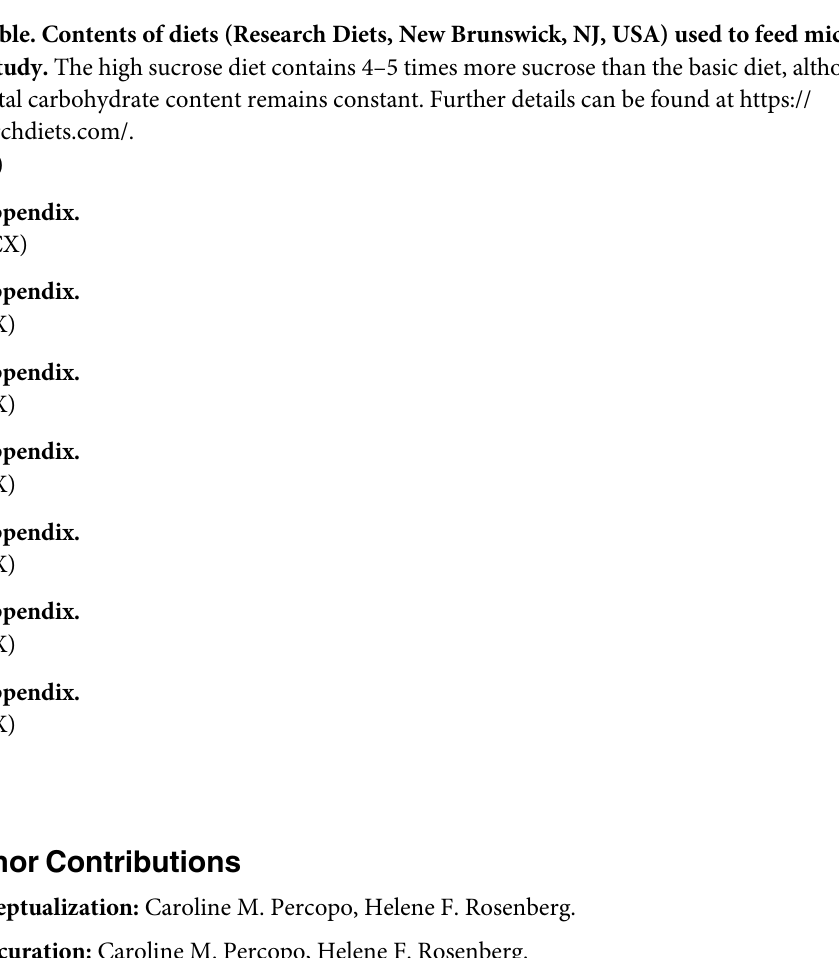
S3 Fig. Profiler signals from cytokines detected in lysates of eosinophils isolated (as shown in Fig 4A) from Aa -challenged mice maintained on ( A ) high-sucrose or ( B ) high- fat diets normalized to those from Aa -challenged mice maintained on a basic diet. Shown are the results presented from three independent experiments; each point represents n = 5 mice as described in the Methods. Arrows indicate no increase over signal detected in mice on the basic diet (i.e., fold change = 1.0); § p < 0.001 vs . theoretical mean (= 1.0), one- sample t-test. S1 Table. Contents of diets (Research Diets, New Brunswick, NJ, USA) used to feed mice in this study. The high sucrose diet contains 4–5 times more sucrose than the basic diet, although the total carbohydrate content remains constant. Further details can be found at https://